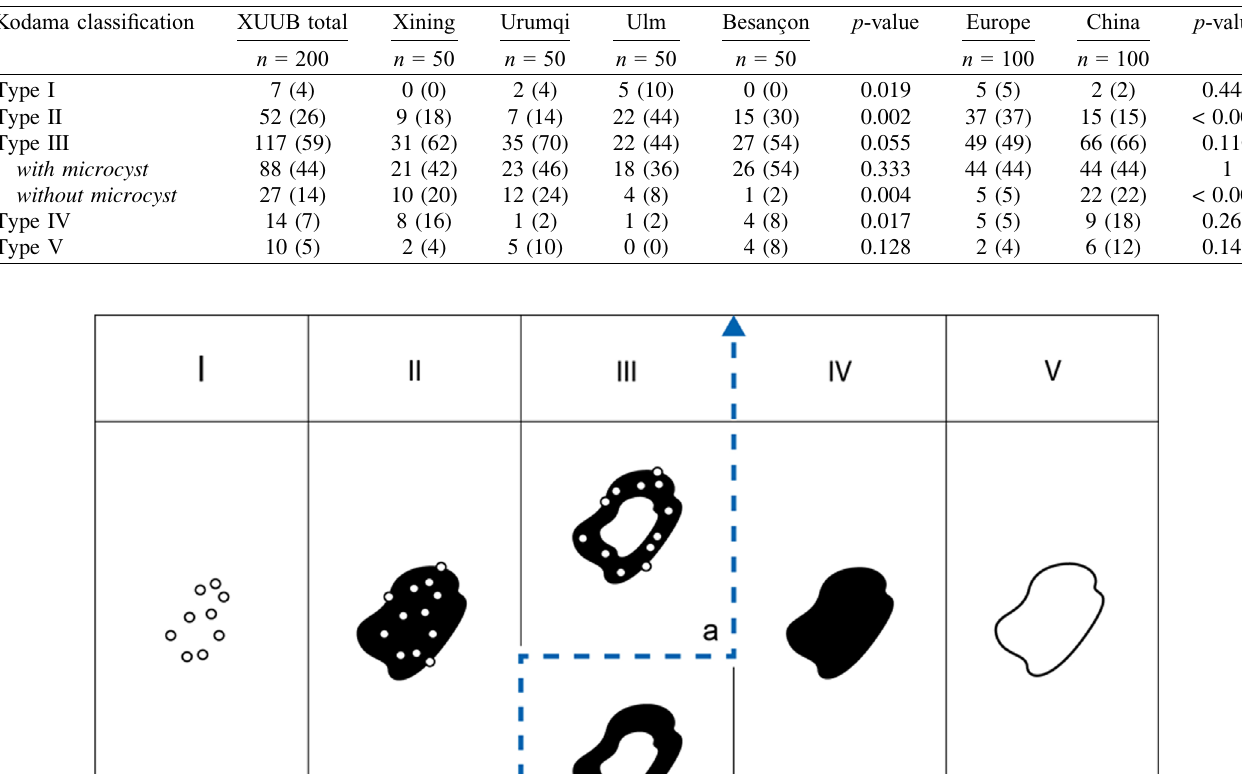
Table 2. International distribution of the Kodama types including presence of microcyst or not in type III patients.